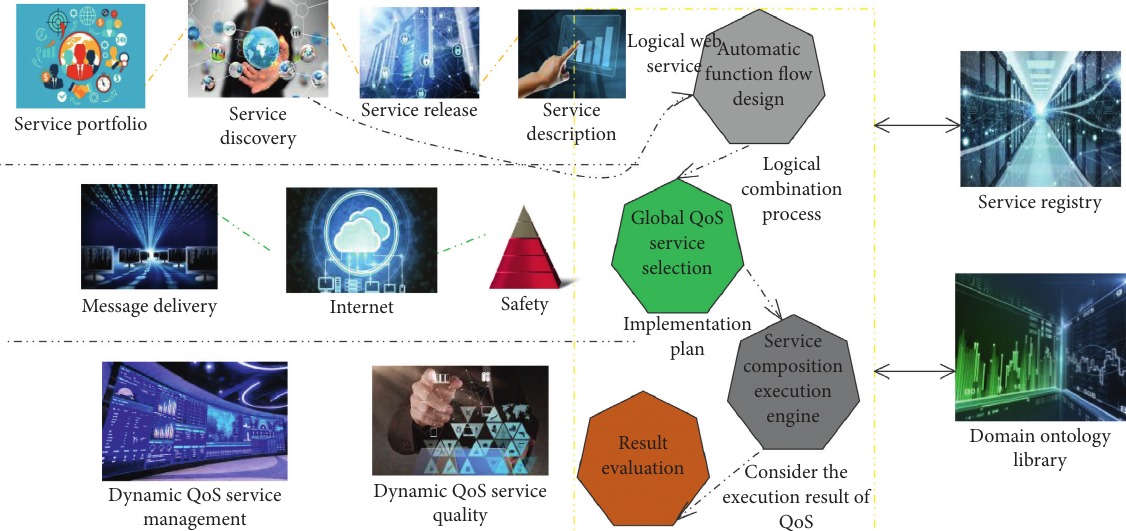
Figure 3: Web service discovery and composition framework based on